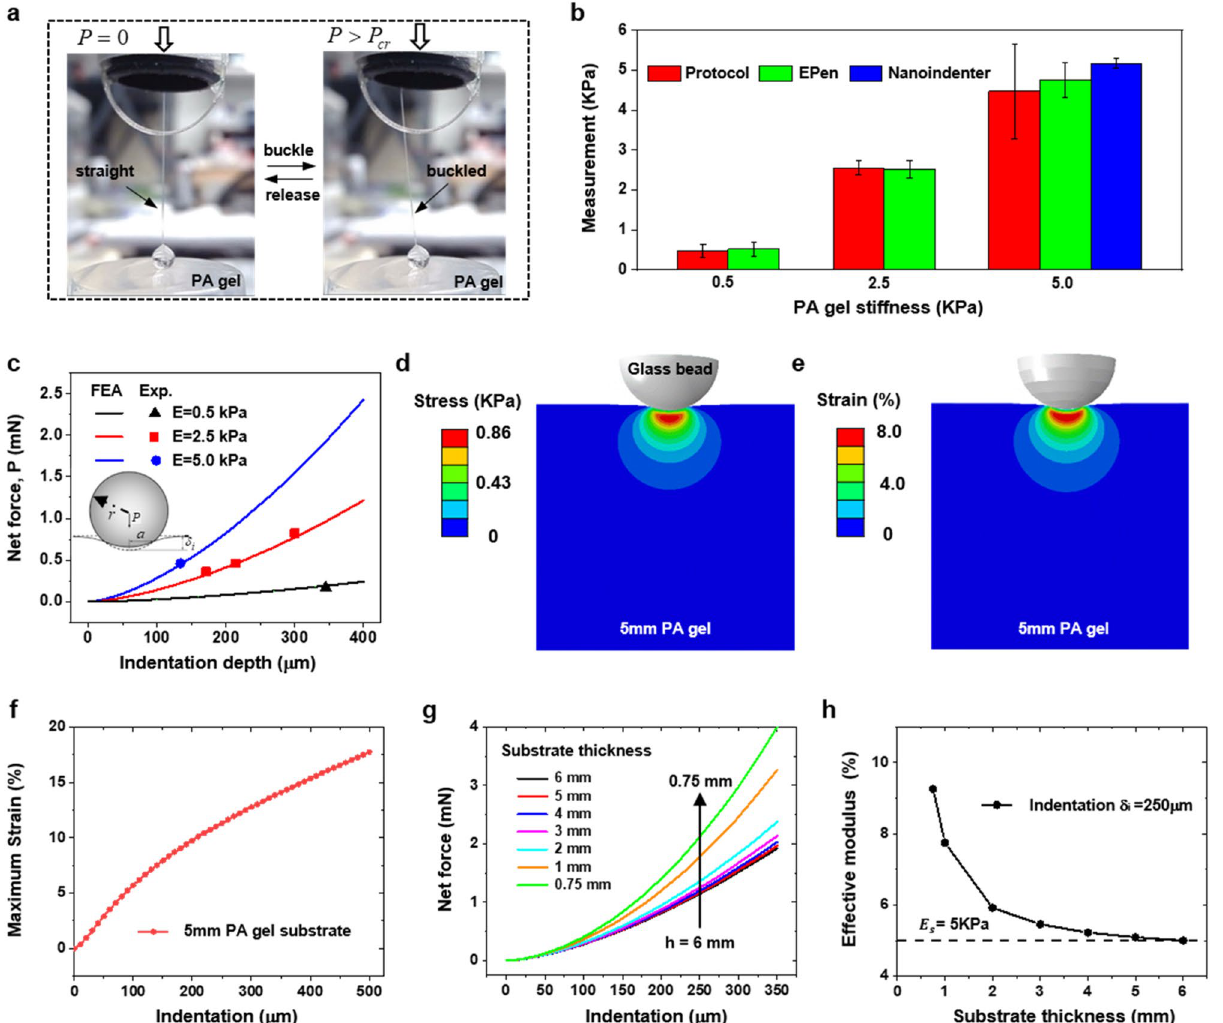
Figure 4. Testing and validation. ( a ) Optical images of glass bead of the EPen to probe the modulus of PA gel by harnessing the buckling of glass fiber. ( b ) Comparison between the stiffness measurements of 0.5, 2.5 and 5 kPa PA gel obtained by fabrication protocol, EPen and nanoindenter respectively. ( c ) Measurements of net force as a function of indentation depth obtained from the experiment (dots) which agrees very well with FEA results (lines) for 0.5, 2.5 and 5 kPa PA gel respectively. ( d , e ) The stress and strain contours of 5 mm PA gel with elastic modulus of 5 kPa under the spherical indentation of 134 μm. ( f ) Maximum strain in the PA gel substrate depending on the spherical indentation. ( g ) Net indentation force versus the spherical indentation amount with various substrate thickness. ( h ) Simulated effective modulus depending on the substrate